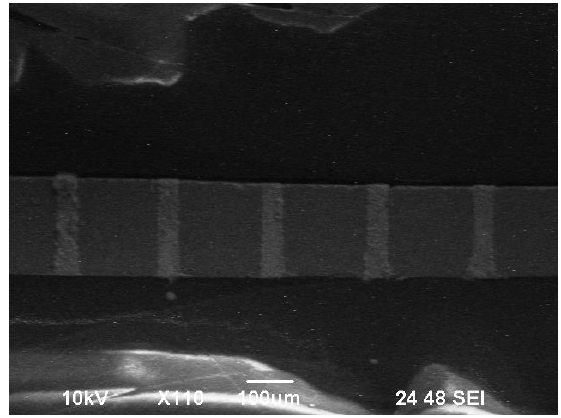
Figure 8. Scanning electron microscope (SEM) image of TSV filling quality.